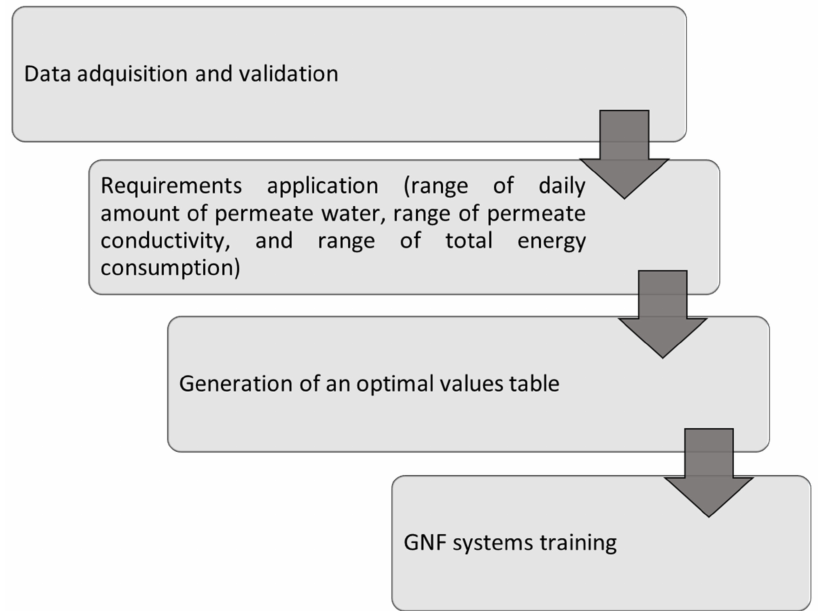
Figure 3. Flow chart of methodology.